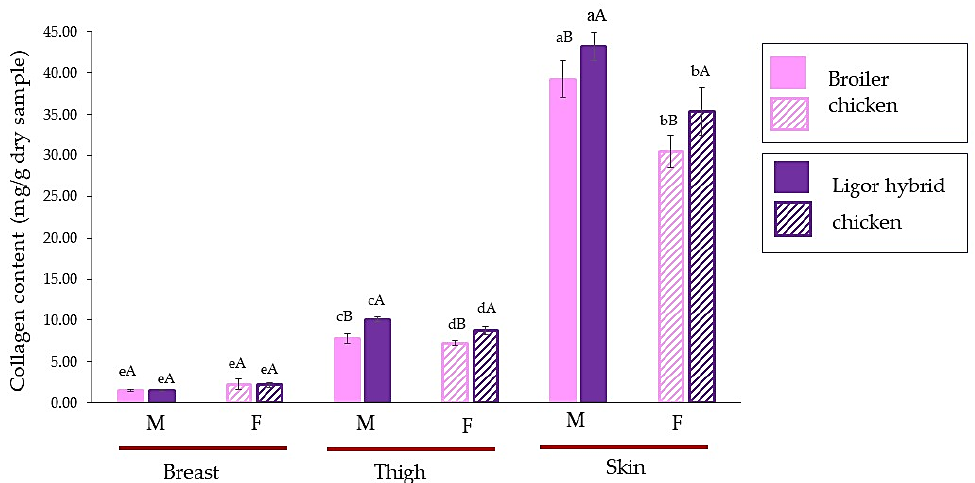
Figure 1. Collagen content (mg/g dry sample) of breast, thigh, and skin of broiler and Ligor hybrid chicken from different sexes. Different lowercase superscripts (a–e) on the bar within the same genotype of chicken indicate significant differences ( p < 0.05). Different uppercase superscripts (A,B) on the bar under the same part and sex of chicken indicate significant differences ( p < 0.05) by T -test. M, male chicken; F, female chicken.